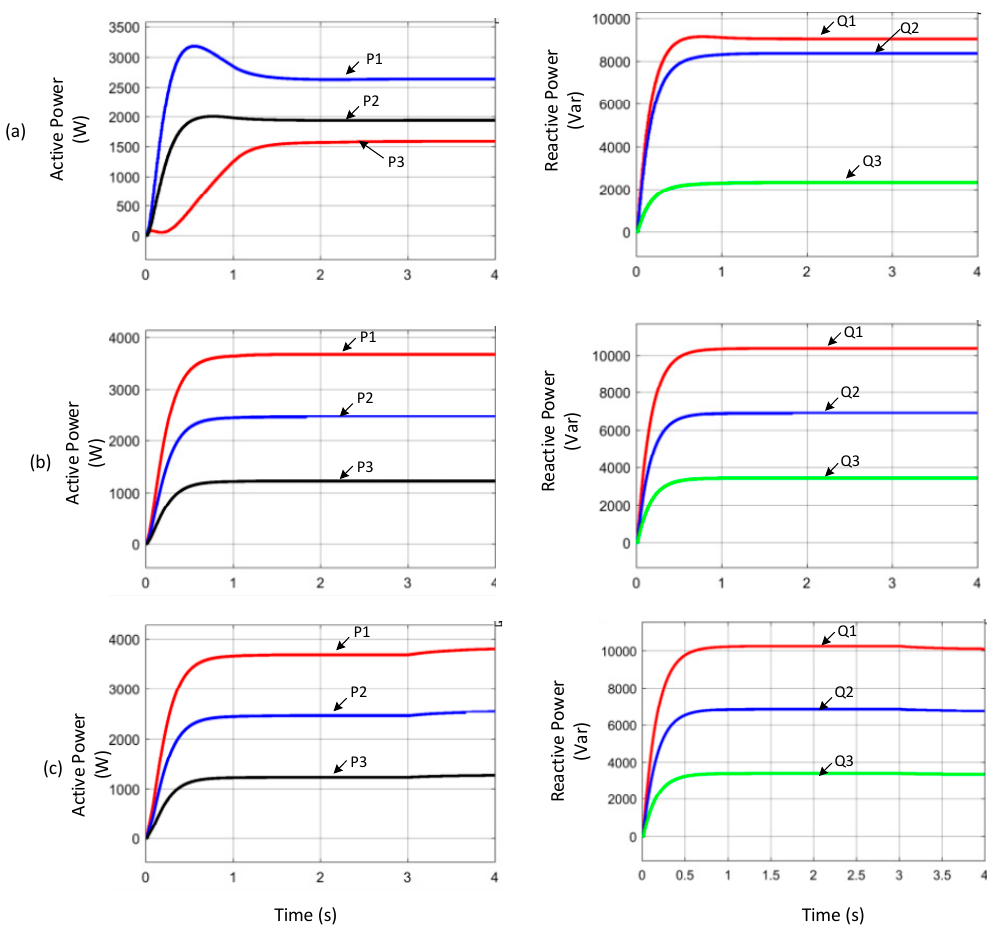
Figure 9. Power sharing among the DGs. ( a ) First step (without harmonic current compensation); ( b ) second step (with harmonic current compensation); ( c ) third step (enabling the APF). Where P1, P2, P3 is the active power sharing of DG1, DG2 and DG3 respectively. Similarly Q1, Q2, Q3 is the corresponding reactive power sharing of DG1, DG2 and DG3 respectively.